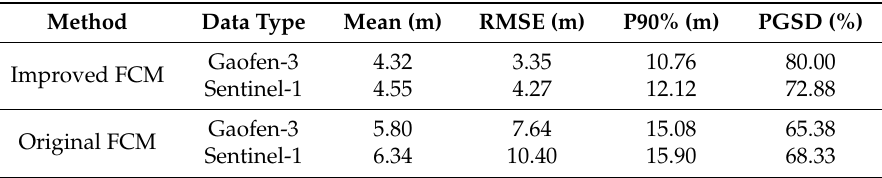
Table 5. Quantitative evaluation in the sub-region of